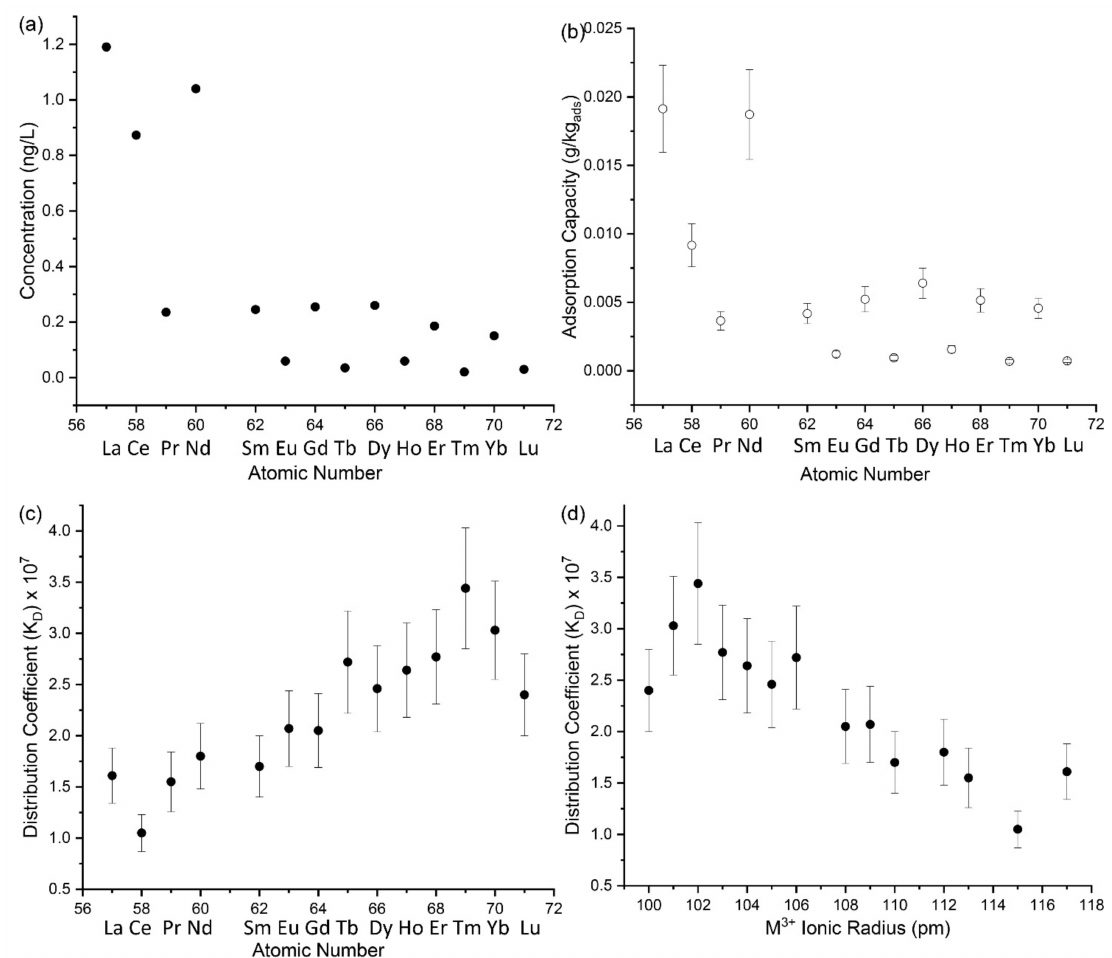
Figure 4. ( a ) Concentrations of lanthanides in western Pacific Ocean water (depth = 3 m). The relative standard deviation (RSD) for every REE was ≤ 10% [19]. ( b ) The lanthanides adsorption capacities after 56 days of exposure to filtered Sequim Bay seawater at 20 ◦ C. Relation between the distribution coefficients (K D ) of lanthanides on the acrylic fiber-based adsorbent to ( c ) atomic numbers of the lanthanides and ( d ) ionic radii of the trivalent lanthanides (Lu 3+ is on the left side in ( d )). Note: The error bar was calculated from nine samples ( N =